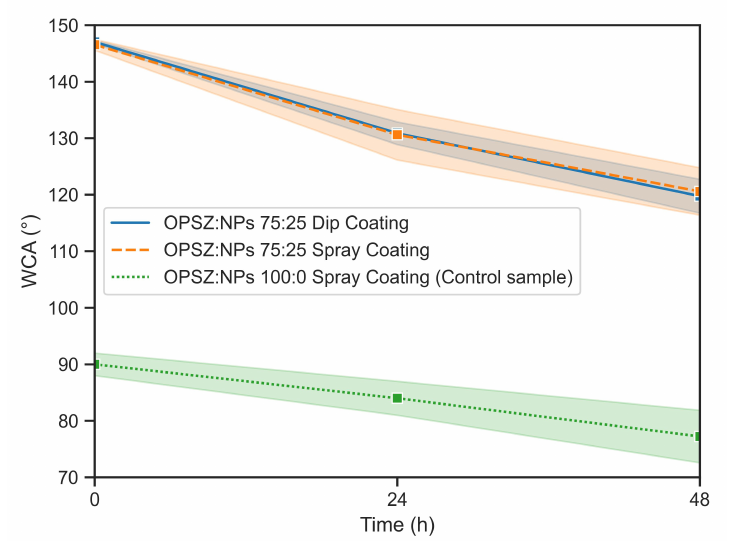
Figure 9. Contact angle measurements versus salt spray test time (shadowed area corresponds to the standard deviation).